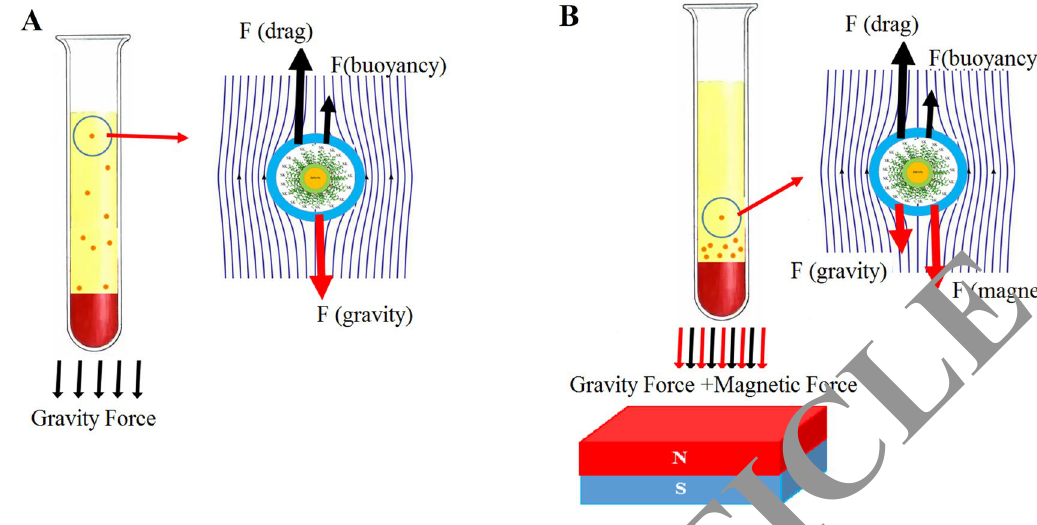
Figure 7. The schematic of the effect of different forces on magnetic nanoparticle ( A ) gravity force, ( B ) magnetic force.